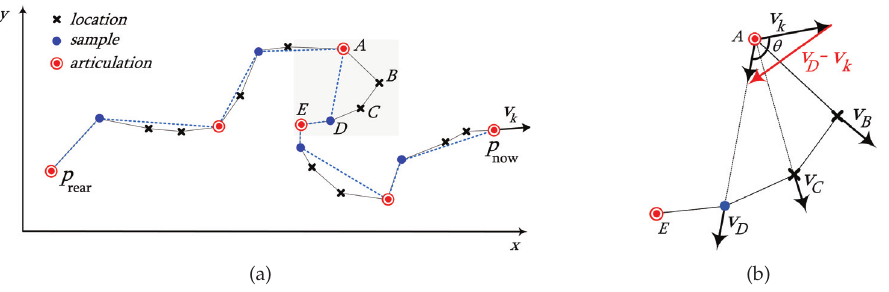
Figure 6: Scaling using velocity vectors: (a) Retain samples that deviate most from currently known velocity (cid:11)v k across window frame W k . (b) For each floating point in current batch (the shaded box in (a)), find its velocity vector w.r.t. anchor point A . Then, choose samples by decreasing difference of their vectors from velocity (cid:11)v k